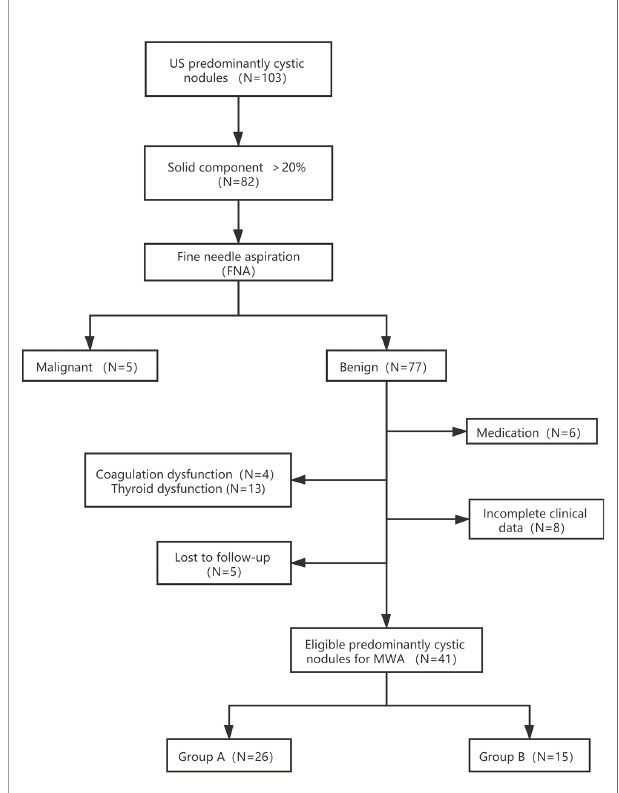
FIGURE 1 | Flowchart of study participants included and excluded in the study. Group A: Aspiration neddle tract was ablated prior to cyst fl uid aspiration. Subsequently, the MWA for the entire nodule was proformed. Group B: MWA was performed directly after aspiration of internal cyst fl